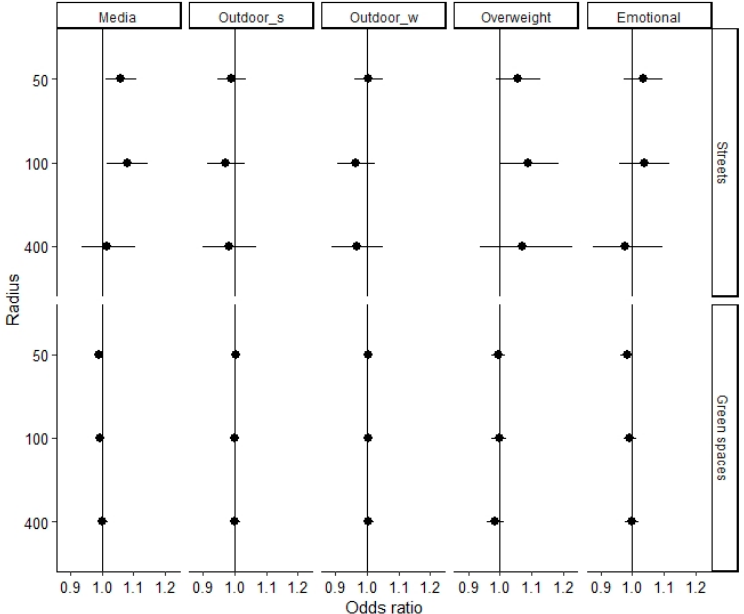
Figure 1. Associations ( + 95% CI) between parameters of the urban living environment and high media use (Media), frequent outdoor activity in summer (Outdoor_s) and winter (Outdoor_w), overweight/obesity (Overweight) and emotional problems (Emotional) in the sample of 3–10-year-old children. All associations are adjusted for child sex, age, family SES (composite score) and local SBR rate.